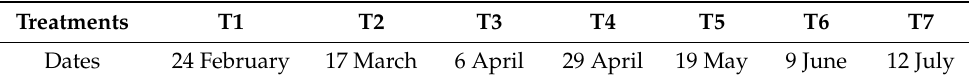
Table 1. Application dates of treatments (control and SA at 0.5, 1 and 5 mM) throughout the developmental and growth cycle of ‘Herminio’ green pepper fruit. Treatments